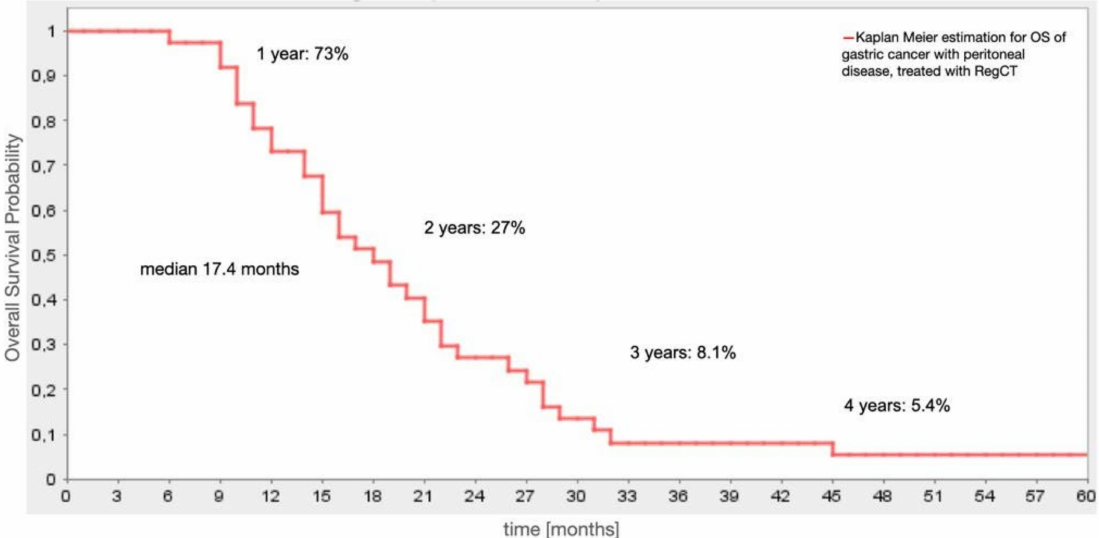
Figure 2. Overall survival of the entire patient cohort ( N =